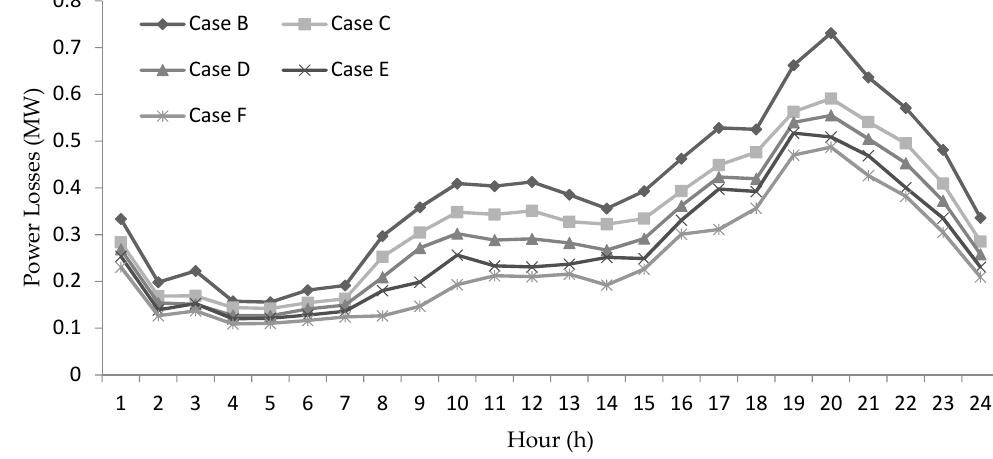
Figure 5. The power losses in the network associated with each case.